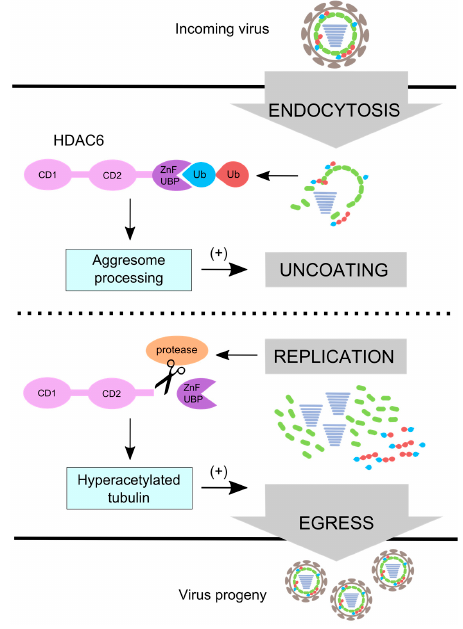
Figure 4. IAV uses HDAC6 differentially during entry and egress. IAV uses aggresome processing and unanchored ubiquitin chains in an HDAC6 ZnF ‐ UBP ‐ dependent manner to promote capsid uncoating during entry. During replication IAV induces ZnF ‐ UBP cleavage by caspase 3 [83] which inactivates virus uncoating activity. Microtubules become hyperacetylated [59] and promote viral egress [90]. The red ubiquitin (Ub) depicts ubiquitin that is anchored, and the blue ubiquitin depicts unanchored ubiquitin with a free C ‐ terminus.